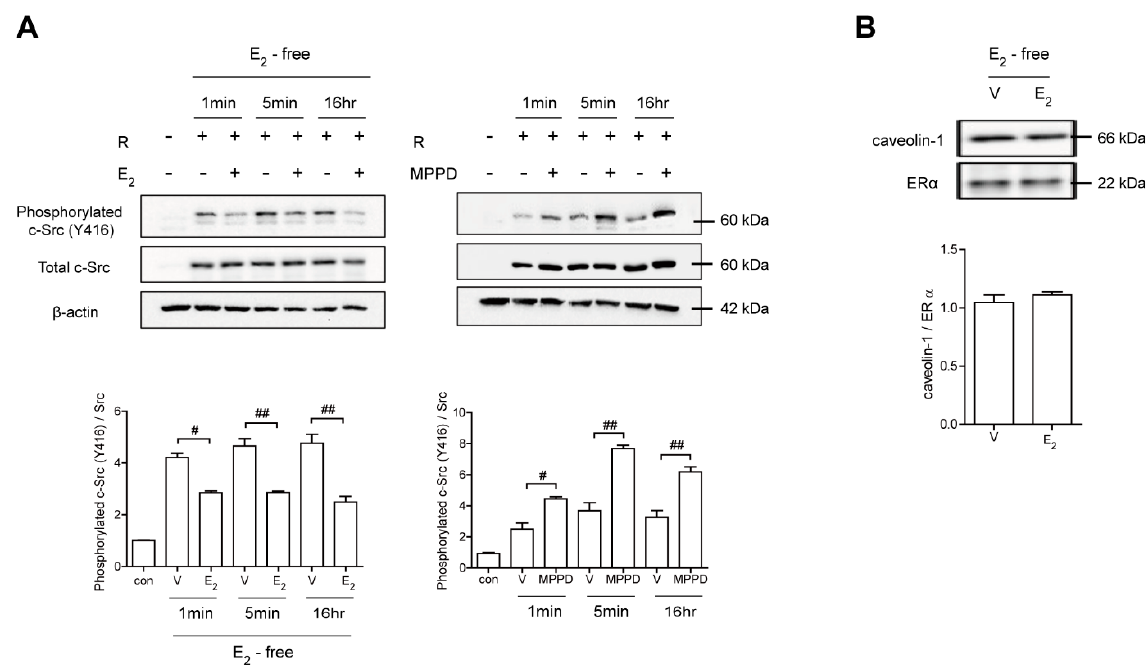
Figure 4. E 2 transmits signaling via ER α , resulting in disrupted c-Src activation in a non-genomic manner. BMMs stimulated with RANKL (50 ng/mL) in the absence and presence of E 2 (5 nM) or MPPD (2 μ M) for the indicated time. ( A ) The cell lysate was immunoblotted for phosphorylated c-Src (Y416). ( B ) Cell lysates were prepared for co-immunoprecipitation with specific antibodies to ER α and subjected to immunoblotting as indicated. # p < 0.05; ## p < 0.01 compared with each corresponding control. Similar results were obtained in three independent experiments.